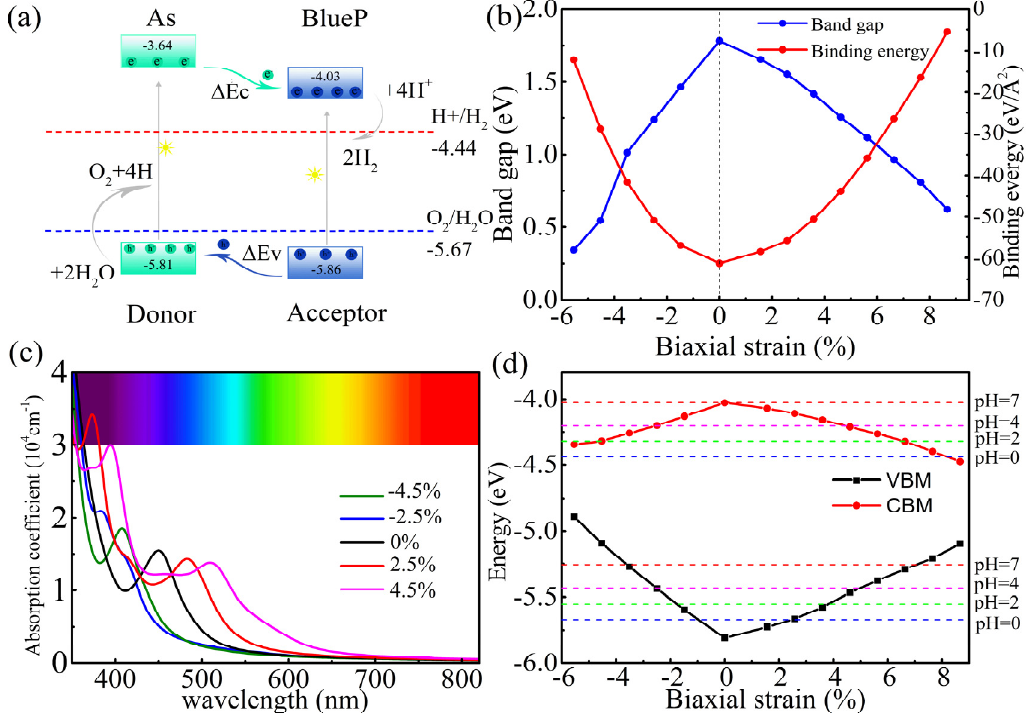
Figure 5. ( a ) Schematic illustration of the type-II photocatalytic mechanism of As/BlueP hetero-structure. The horizontal dash lines indicate the oxidation potential and reduction potential for water splitting. ( b ) Bandgap and binding energy of the As/BlueP hetero-structure as functions of the tunable biaxial strain based on the HSE06 calculation. ( c ) Optical absorption coefficient of As/BlueP hetero-structures with different biaxial strain versus incident light energy. ( d ) Band edge positions of As/BlueP hetero-structure as functions of the tunable interlayer distance. The horizontal dash lines indicate the oxidation potential and reduction potential for water splitting at different pH.